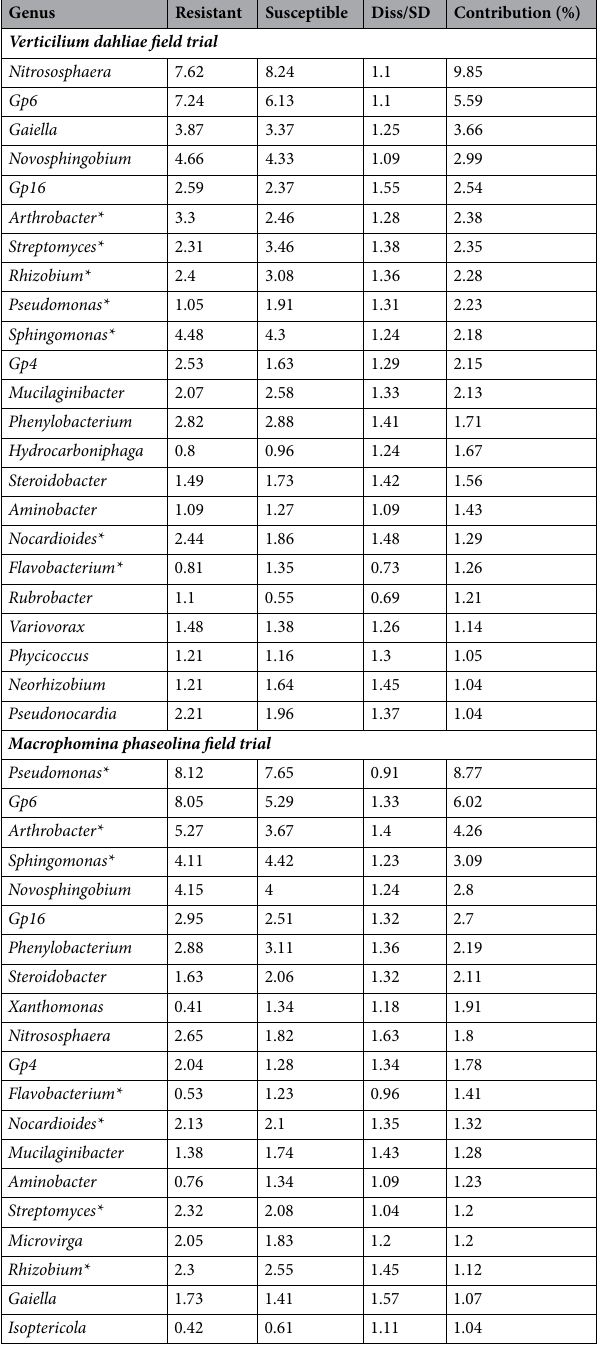
Table 4. SIMPER analysis showing the average percent relative abundances of bacterial genera contributing to at least 1% to the observed variability in the rhizosphere microbiome between cultivars with high and low resistance to Verticilium dahliae and Macrophomina phaseolina . Diss/SD values represent the average dissimilarity divided by the standard deviation. *Potential fungal antagonists 19